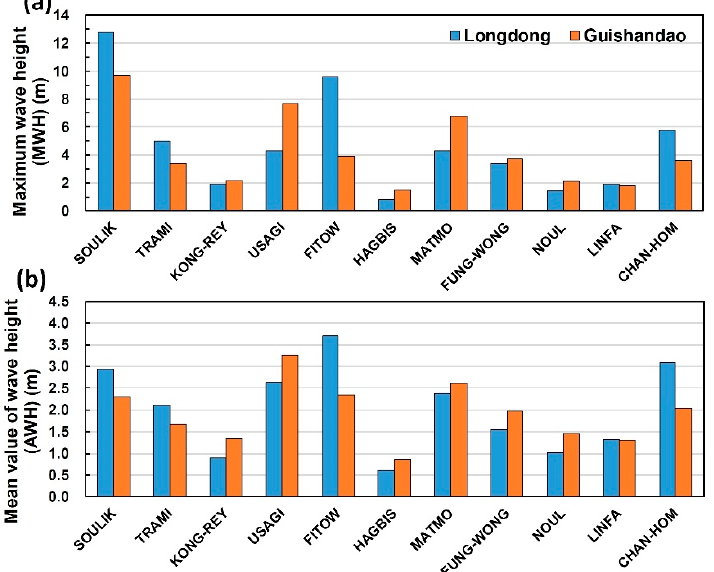
Figure 4. Observation record of ( a ) maximum wave height (MWH) and ( b ) mean value of wave height (AWH) of the 11 typhoons in the testing set.